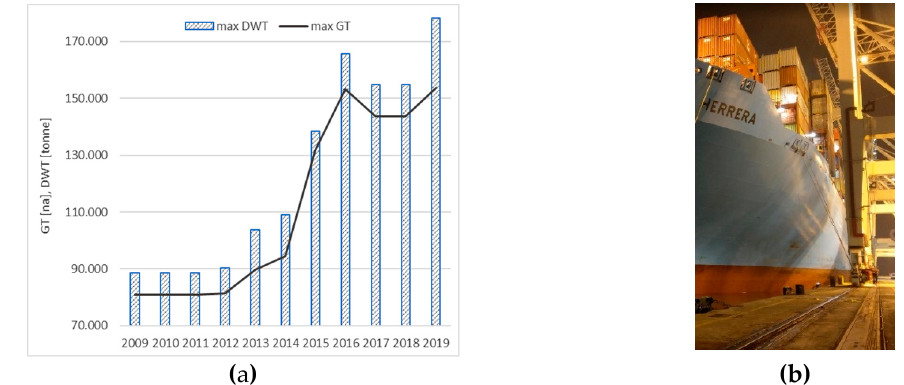
Figure 1. Evolution of the size of container ships calling at Koper ( a ) and ship-to-shore (STS) crane close proximity ( b ).